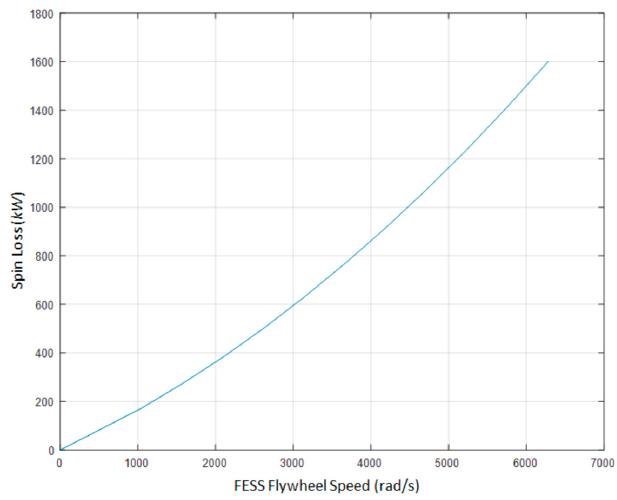
Figure 12. FESS spin loss versus flywheel speed [11]. Table 2. The parameter setup for the PS-FHV simulation.